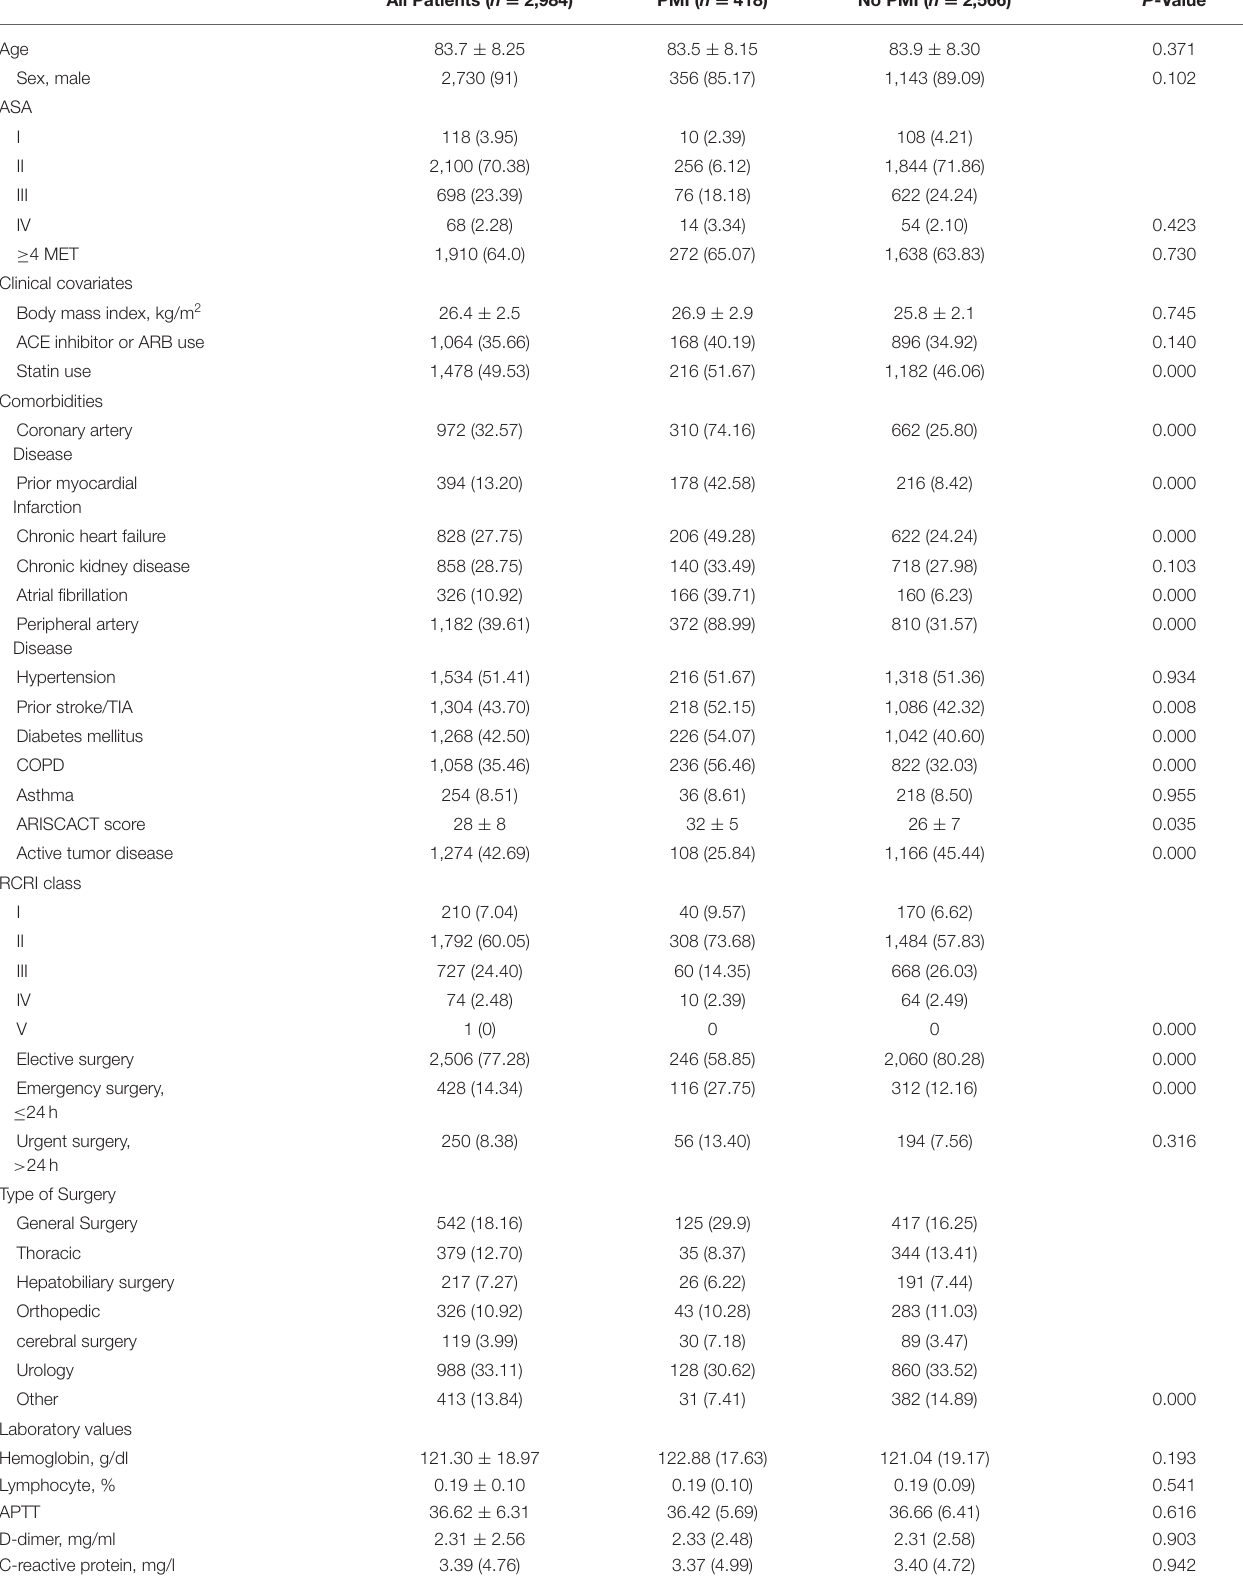
TABLE 1 | Baseline